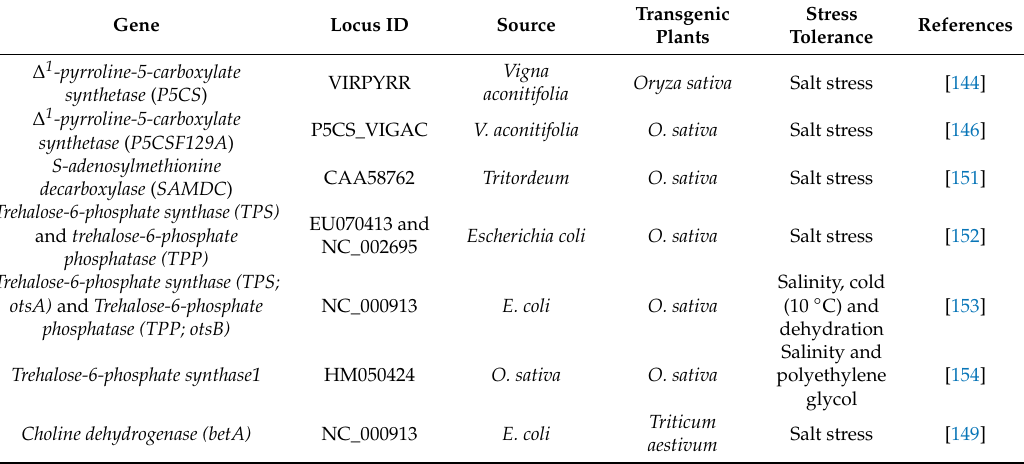
Table 3. Improvements of plant tolerance to salt stress by genetic engineering of metabolic